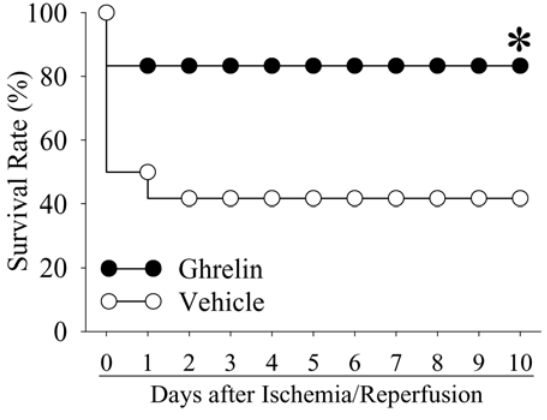
Figure 8. Alterations in intestinal (A) and pulmonary (B) MPO activities, and serum levels of lactate (C) in sham-operated animals (Sham) and ischemia/reperfusion animals treated with normal saline (Vehicle) or [D-Arg 1 D-Phe 5 D-Trp 7, 9 Leu 11 ]-substance P (GA antagonist) at 1.5 h after the completion of treatment (i.e., 2 h after reperfusion). Data are presented as means 6 SE (n=5–6) and compared by one-way ANOVA and Student-Newman-Keuls test: * P , 0.05 versus Sham group; # P , 0.05 versus Vehicle group. Alterations in the survival rate ( D ) at 10 days after gut ischemia/reperfusion with normal saline treatment (Vehicle) and gut ischemia/reperfusion with [D-Arg 1 D-Phe 5 D-Trp 7, 9 Leu 11 ]-substance P (GA antagonist). There were 12 animals in each group. Survival rate in the vehicle treated animals is derived from Figure 7. The survival rate was estimated by the Kaplan-Meier method and compared by using the log-rank test. * P , 0.05 vs. Vehicle.